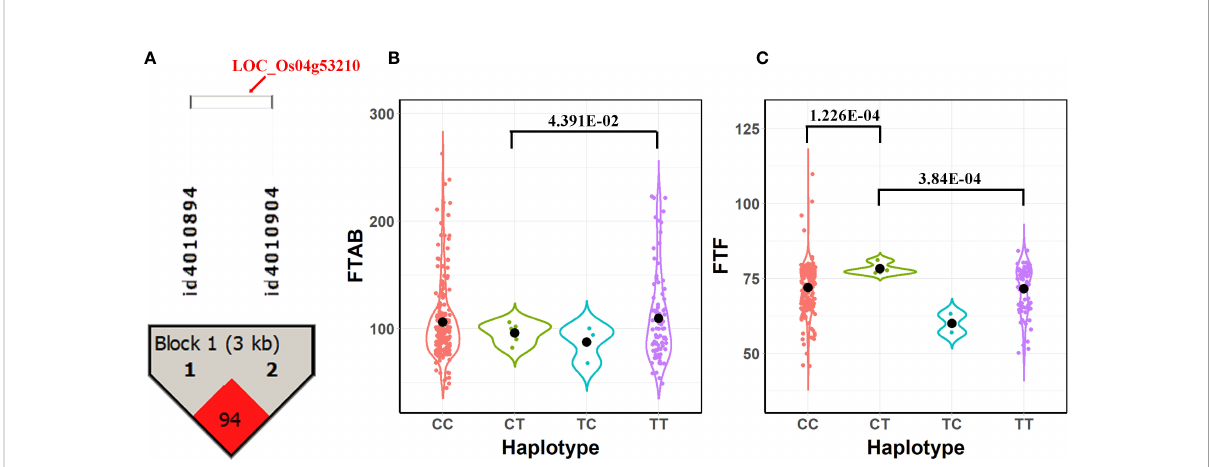
FIGURE 4 Results of haplotype and phenotypic difference analysis for the candidate gene LOC_Os04g53210. (A) Linkage disequilibrium and haplotype block with two SNPs inside for LOC_Os04g53210. (B) Comparison of FTAB among haplotypes CT, CC, TC, and TT. (C) Comparison of FTF among haplotypes CT, CC, TC, and